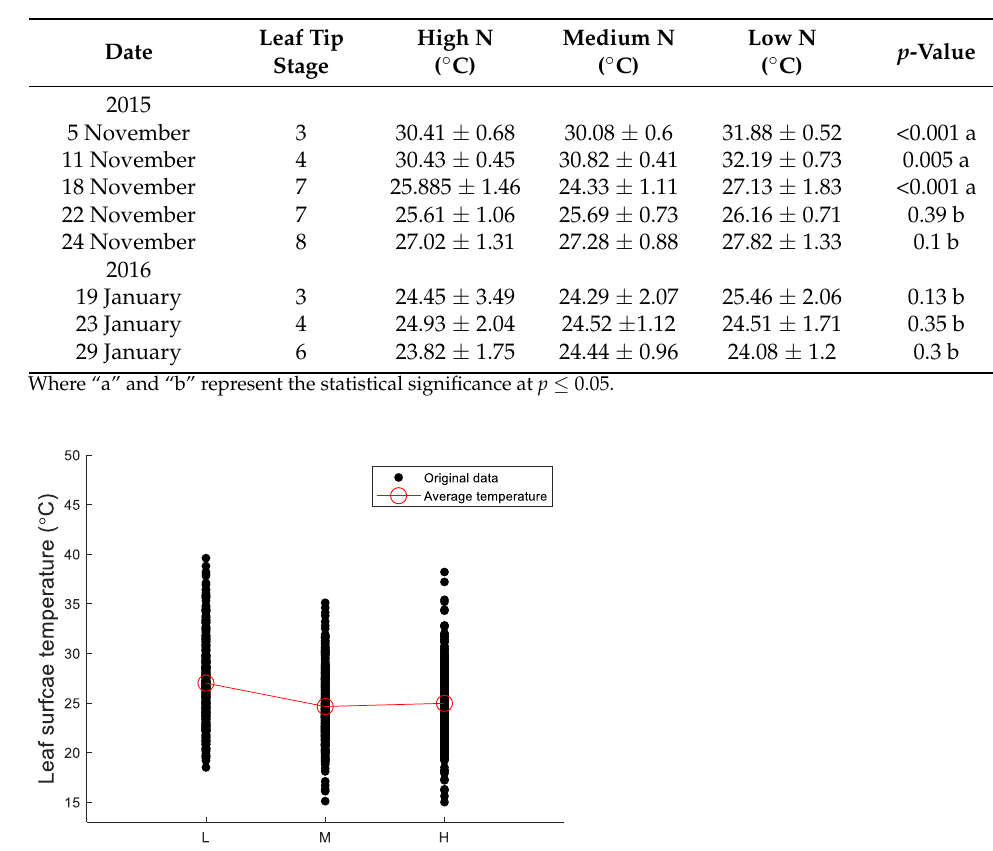
Table 5. The mean leaf surface temperature increases with nitrogen stress in the two experiments conducted in the greenhouse, using the thermal camera data.